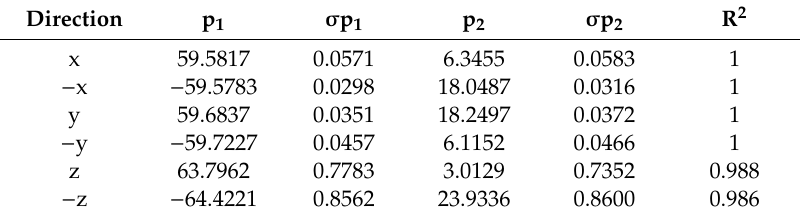
Figure 5. Current supplying the coils vs. the magnetic field generated in the central volume; blue plot—measurements in the positive sensor direction, red plot—measurements in the negative direction, where positive relates to the same direction as the magnetic field vector and negative relates to the opposite. For both series of data, linear fit was calculated, as well as 95% prediction interval. Measurement directions (x, y, z) correspond to the coordinate system in Figure 2. Table 1. Linear regression coe ffi cients in descending powers (p1 and p2) with a standard error ( σ p 1 and σ p 2 ) and determination coe ffi cients R2 of linear regression B[nT] = p1 I[mA] + p2 calculated for the measurements done in each